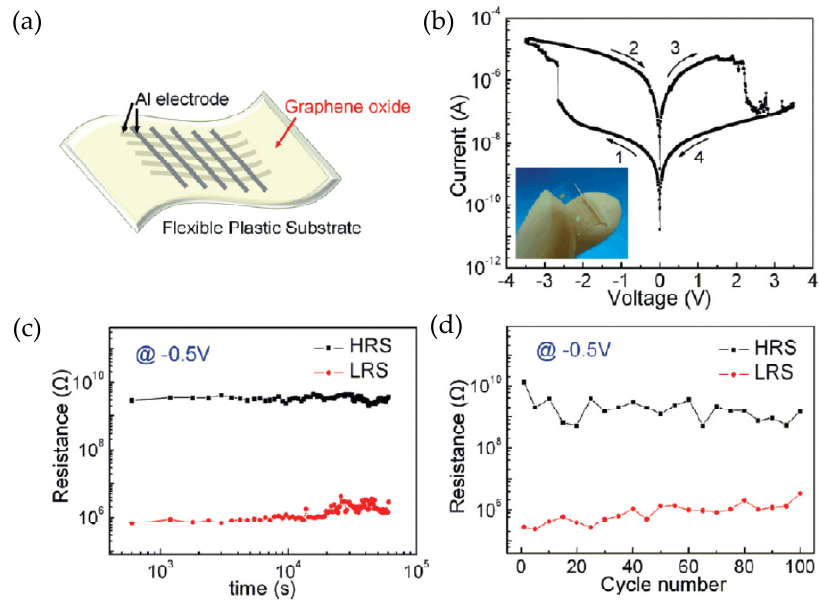
Figure 4. ( a ) Schematic illustration of Al / GO / Al / PES flexible crossbar memory device; ( b ) Typical I–V characteristic of Al / GO / Al / PES RRAM device; ( c ) Retention property of Al / GO / Al / PES device read at − 0.5 V; ( d ) Endurance performance of Al / GO / Al / PES device measured during 100 sweep cycles